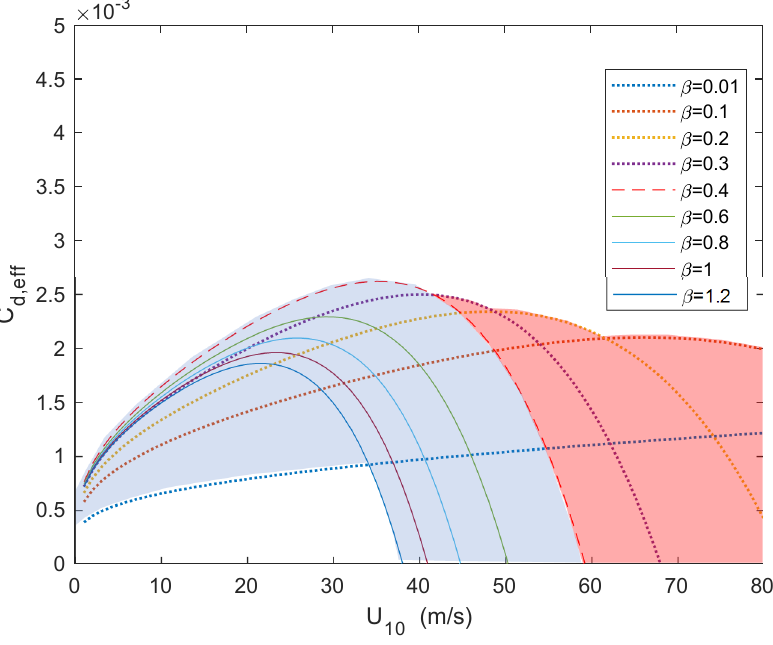
Figure 10. Influence of wave state on the drag coefficient.